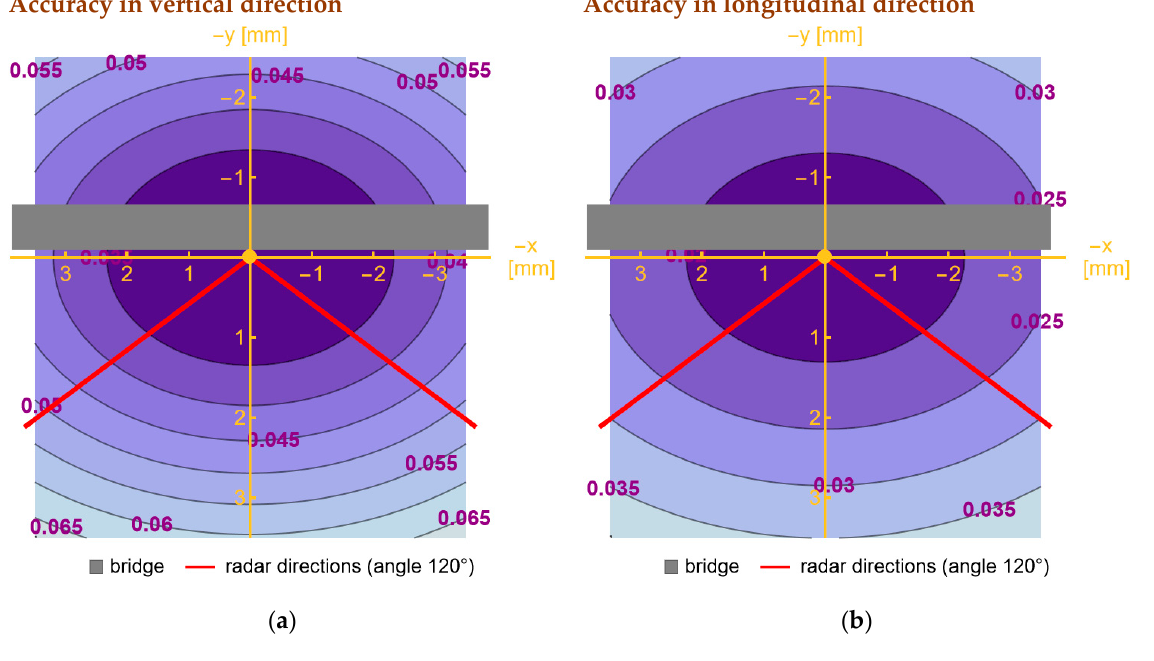
Figure 8. Standard deviations when the radars are located at opposite ends of the bridge (vertical angles of radar directions are 30 ◦ and 150 ◦ ). The angles are determined with precision 0.5 ◦ . Standard deviation of measured LOS displacement is 0.02 mm. Numeric values on the axes and on the isolines are in mm: ( a ) Standard deviation σ y ; ( b ) Standard deviation σ x .